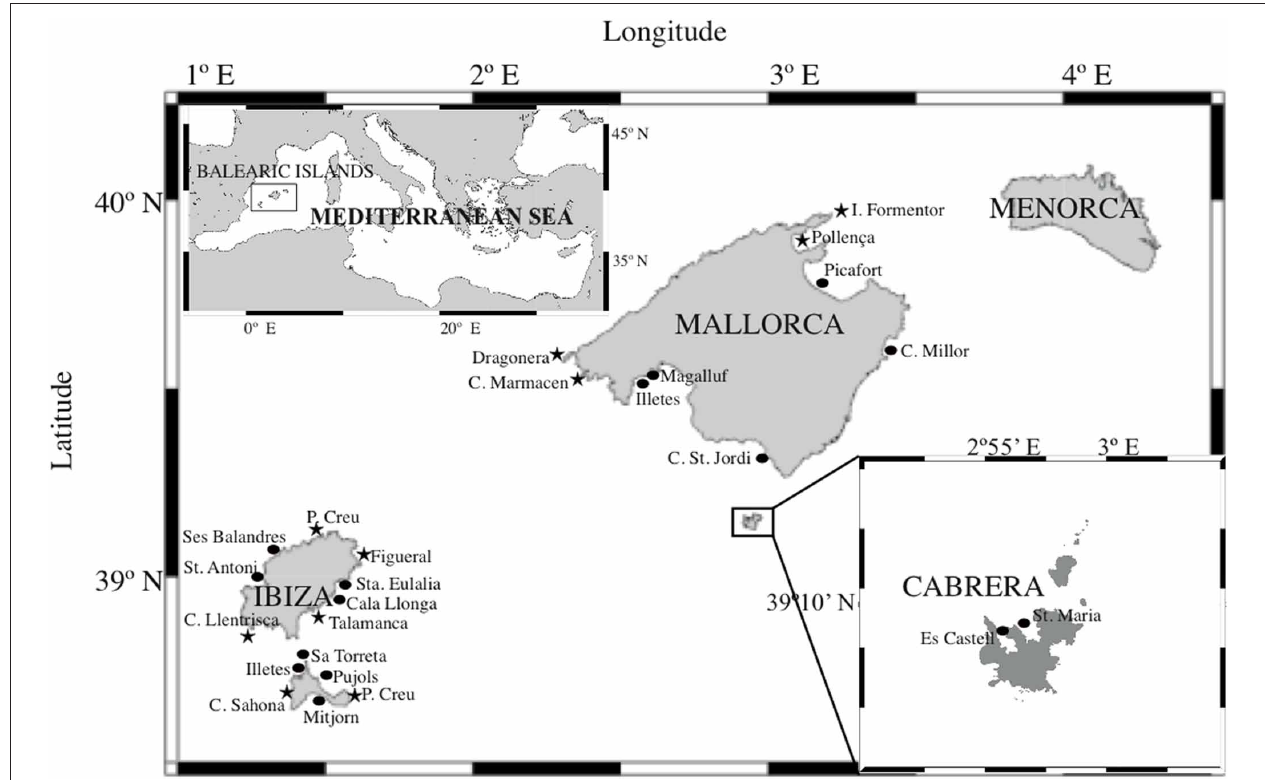
FIGURE 1 | Location of P. oceanica meadows sampled in summer 2005 (circles) and summer 2006